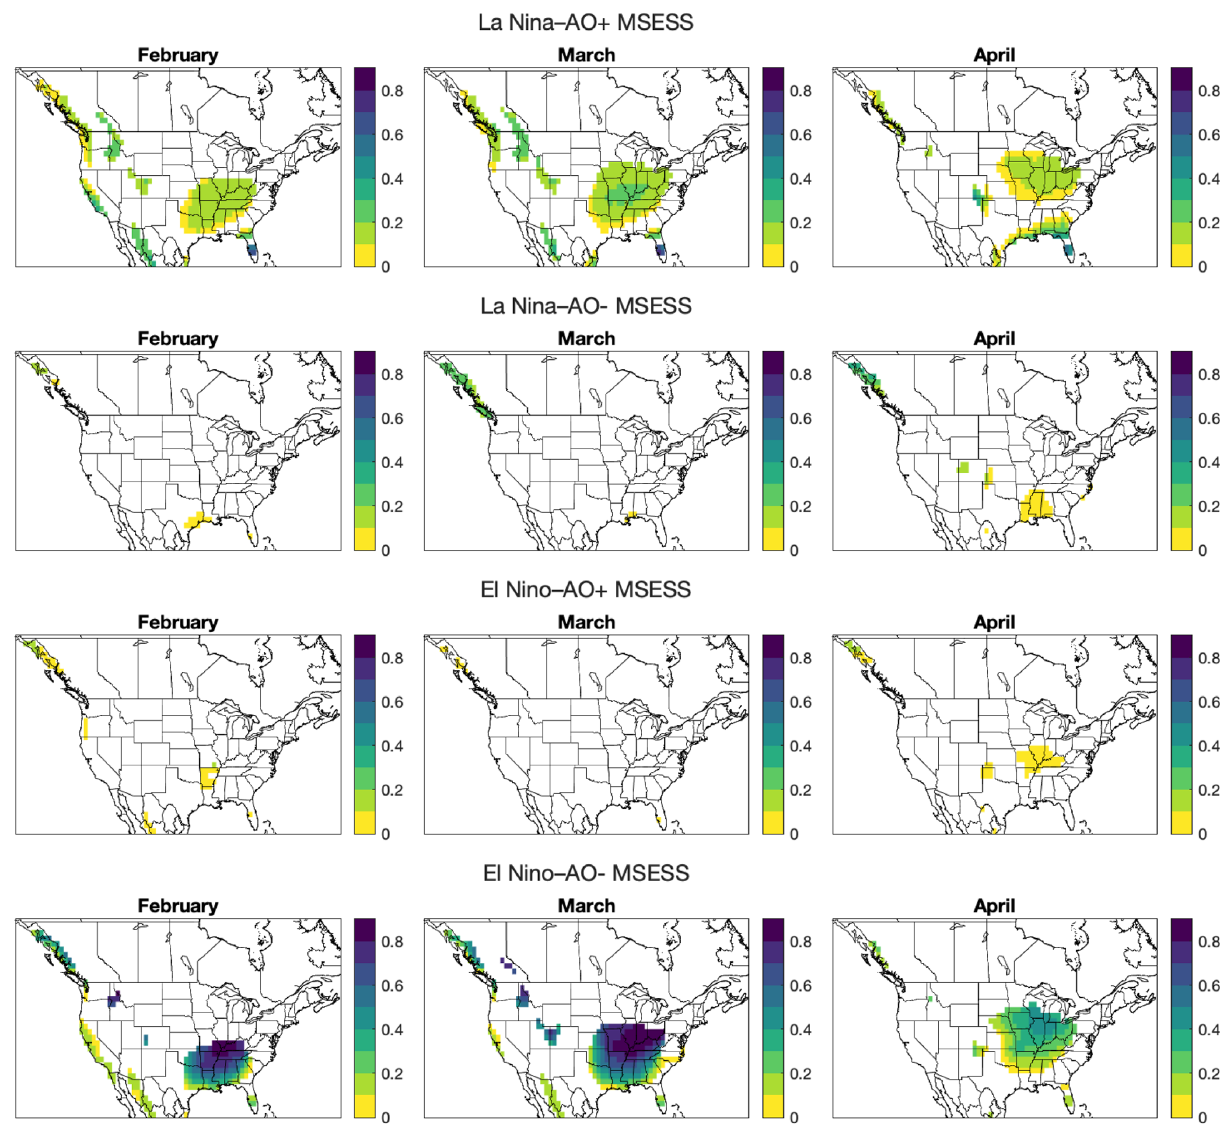
Figure 3. Perfect model mean squared error skill score (MSESS) for February, March, and April bivariate Niño 3.4–AO composites of TEI. MSESS values are masked as in Fig. 2 and where MSESS values are less than